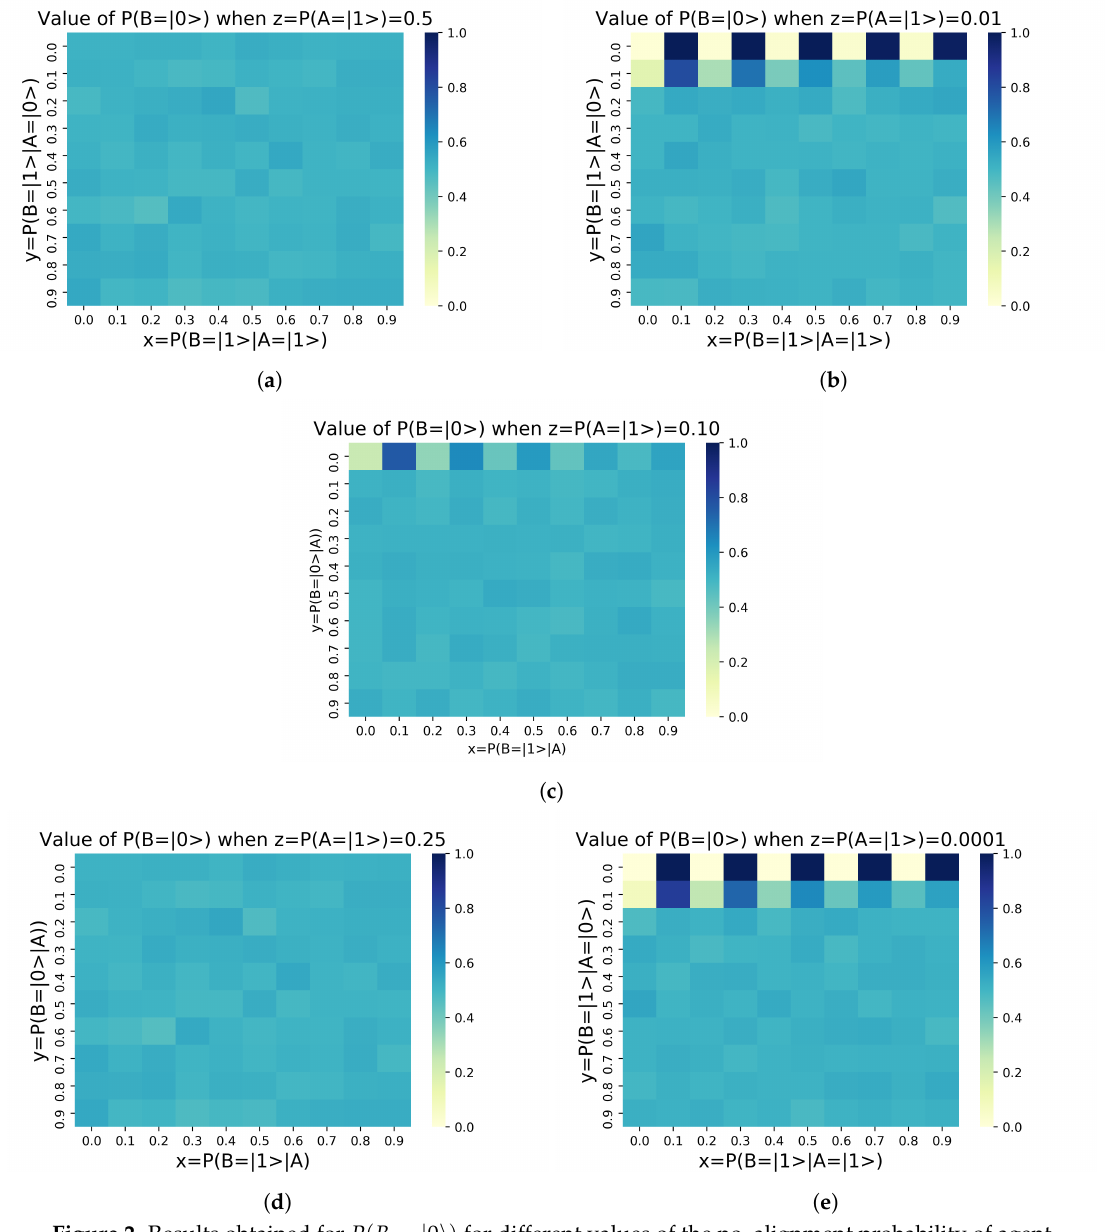
Figure 2. Results obtained for P ( B = A , z = P ( A = ( e ) P(A =